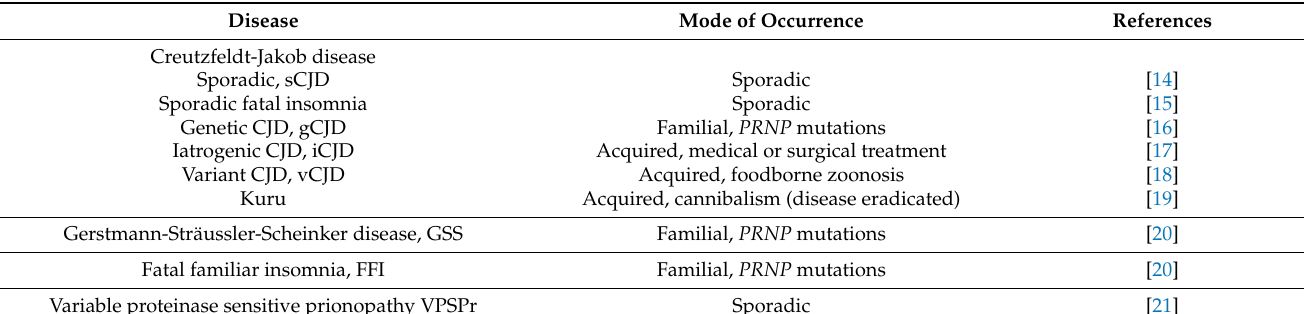
Table 1. Human prion diseases and their epidemiological profile.